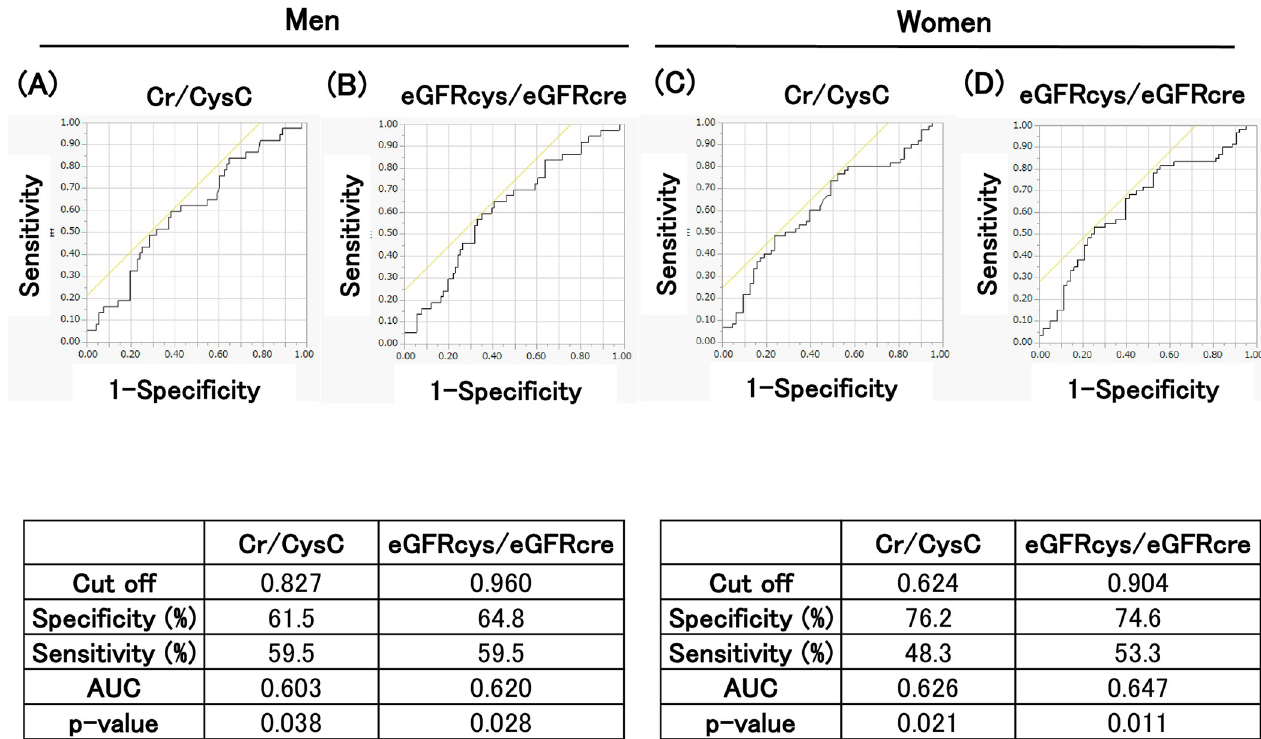
Fig 2. ROC and AUC of Cr/CysC (A) and eGFRcys/eGFRcre (B) for OFI-8 � 4 in men. ROC and AUC of Cr/CysC (C) and eGFRcys/eGFRcre (D) for OFI- 8 � 4 in women. ROC, receiver operating characteristic curves. AUC, area under the curve.